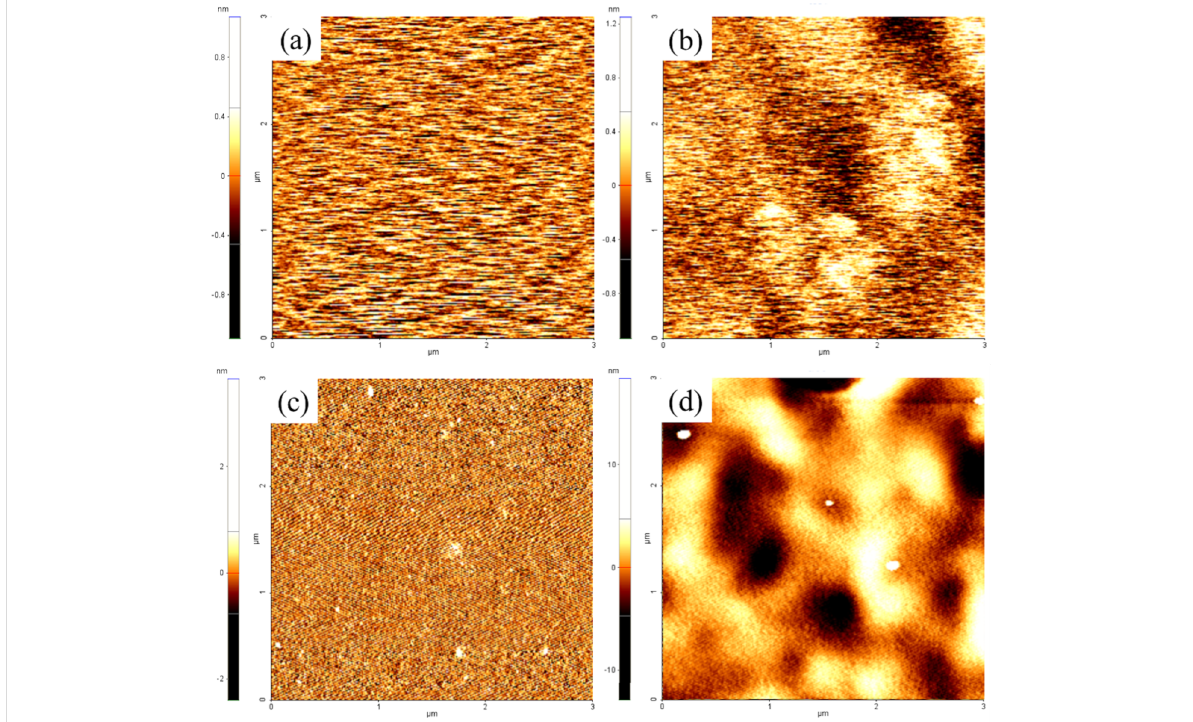
Figure 1: Typical AFM images of Si substrates before (a) and after (b) ODS-monolayer formation, (c) FAS17-monolayer formation, and (d) C 10 -hybrid film formation (scan areas are 3 × 3 μ m 2 ).